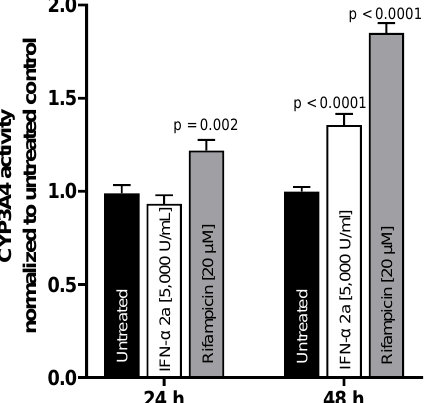
Figure 4. CYP3A4 metabolic activity in LS180 cells after exposure to 5000 U/mL IFN- α 2a (white bars) or 20 µM rifampicin (gray bars) for 24 h or 48 h, respectively. Luminescence values of drug-treated samples were normalized to luminescence of untreated control samples (black bars). Data shown are